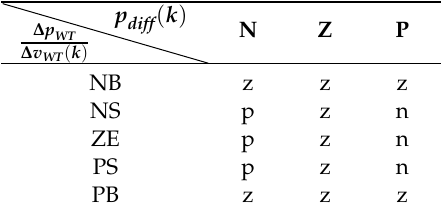
Table 1. Rule base for LPPT mode. (N: negative; P: positive; Z: zero; S: small; B: big)